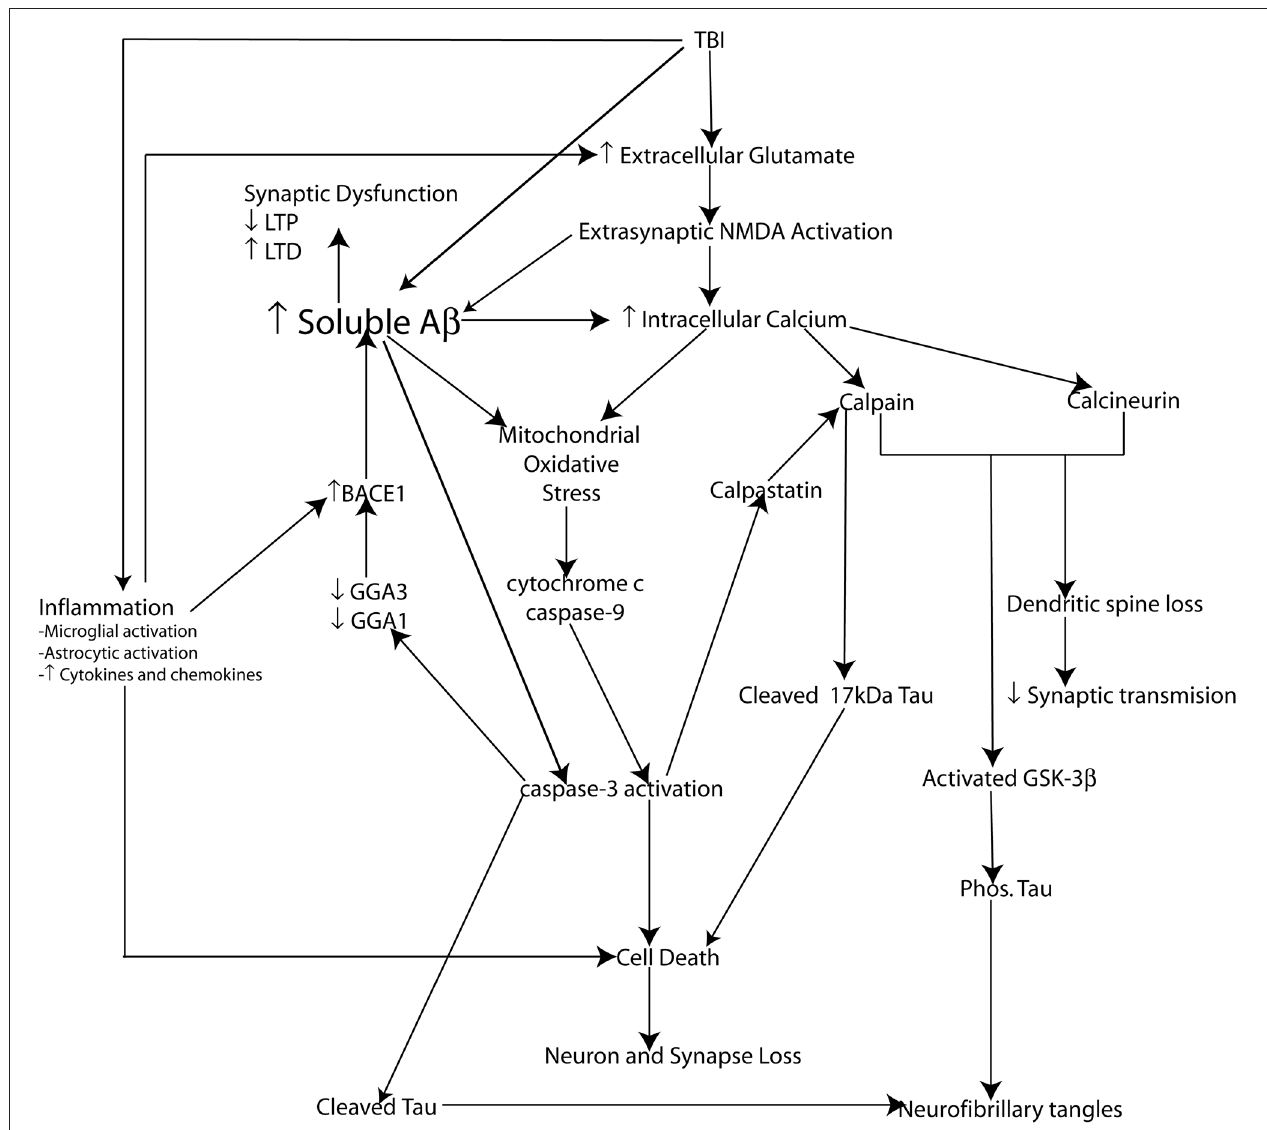
FIGURE 4 | Schematic representation of potential molecular mechanisms modulating A β and Tau pathology following injury. Loss of neurons, synapses, and dendritic spines as well as elevated soluble A β levels, amyloid plaque deposition along with elevated phosphorylated tau levels and the formation of neurofibrillary tangles (NFT’s) are pathological features common to both traumatic brain injury (TBI) and Alzheimer’s disease (AD). Not surprisingly the pathophysiological mechanisms leading to cell death, synaptic dysfunction and altered A β and tau pathology also overlap. Glutamate mediated excitotoxicity is a key initiator of cell death following traumatic brain injury (TBI). Excessive glutamate induced activation of extrasynaptic NMDA receptors leads to dramatically elevated intracellular calcium levels. Impaired calcium homeostasis in turn initiates a number of crucial downstream cellular injury processes including mitochondrial oxidative stress as well as the activation of the calcium sensitive proteases (caspases and calpains) which have been demonstrated to induce cell death in vitro (and hence loss of neurons and synapses) via caspase-3 activation and the cleavage of tau into a 17kDa toxic tau fragment. TBI induced inflammatory events including activation of microglia and astrocytes and hence